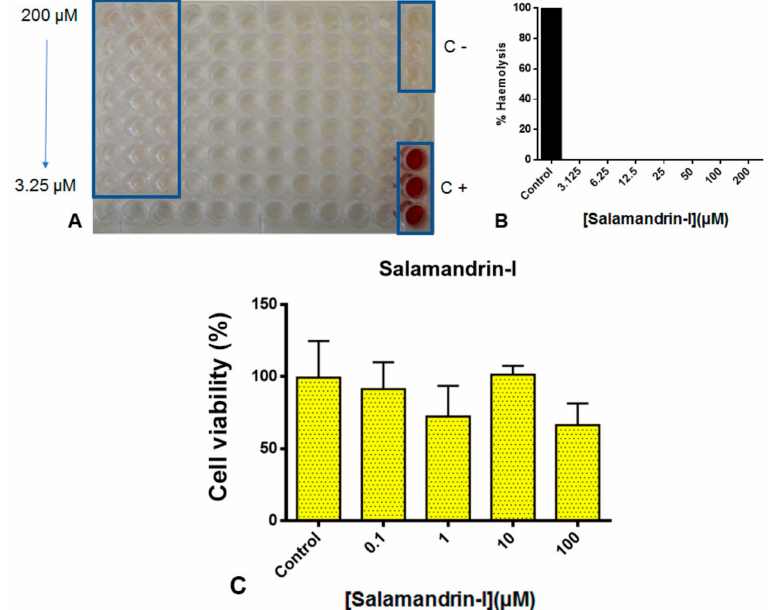
Figure 6. ( A ) Cytotoxicity studies in human microglial cells of salamandrin-I. ( B ) Hemolytic activity of salamandrin-I in human red blood cells / O + . Representative 96-well plate image, PBS pH 7.4 (negative control, C − ) and Triton X-100 0.1% (positive control, C + ). ( C ) Quantitative histogram